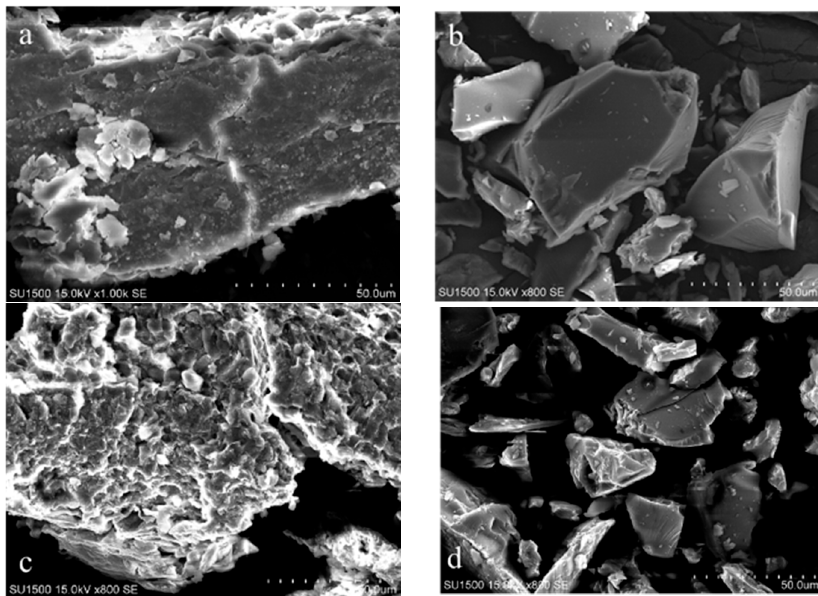
Figure 1. SEM images of tea leaves before and after the crosslinking, ( a ) fresh tea leaves (FT), ( b ) crosslinked fresh tea leaves (CFT), ( c ) used tea leaves (UT), and ( d ) crosslinked used tea leaves (CUT). + Adsorption of Cs ions on crude and crosslinked tea leaves at di ff erent pH values is